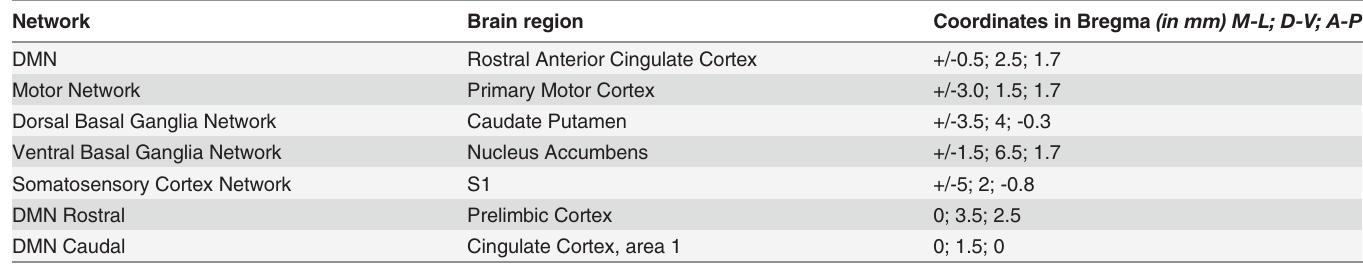
Table 2. Seed placement in rat for; DMN, motor network, dorsal basal ganglia network, and ventral basal ganglia network.